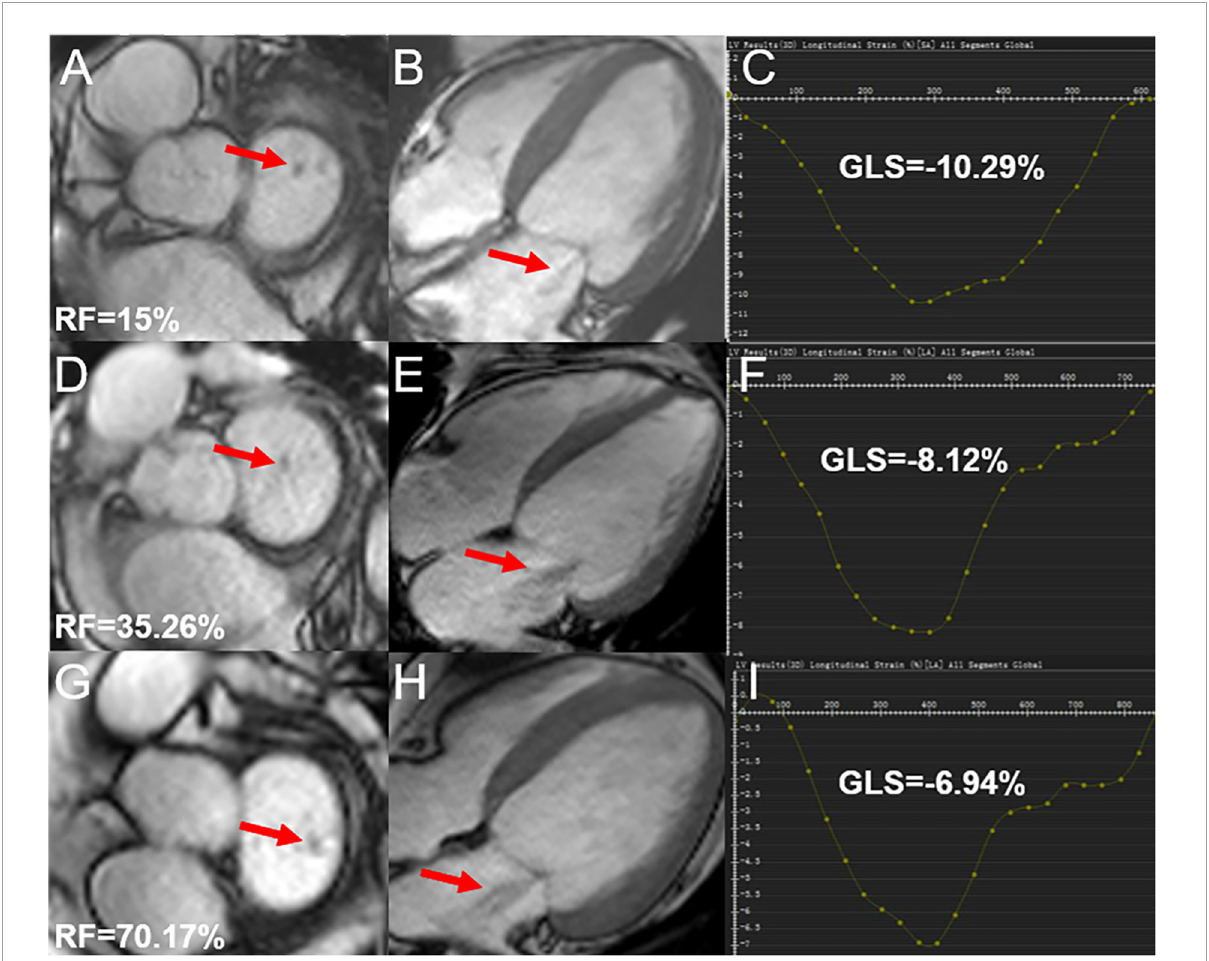
FIGURE3 Cardiac magnetic resonance cine and GLS images in hypertensive cases showing mild, moderate, and severe degrees of regurgitation; (A,B) mild mitral regurgitation patient, male, 72-year-old, RF = 15%, LV short-axis (A) , 4-chamber (B) cine images demonstrating the regurgitation signal from the LV to LA (red arrow); (D,E) moderate mitral regurgitation patient, male, 52-year-old, RF = 35.26%, LV short-axis (D) , 4-chamber (E) cine images demonstrating the regurgitation signal from LV to LA (red arrow); (G,H) severe mitral regurgitation patient, male, 42 years old, RF = 70.17%, LV short-axis (G) , 4-chamber (H) cine images demonstrating abnormally reversed blood flow from LV to LA (red arrow); (C,F,I) the curves for LV GLS. RF, regurgitation fraction; GLS, global longitudinal peak strain; LV, left ventricle; LA, left